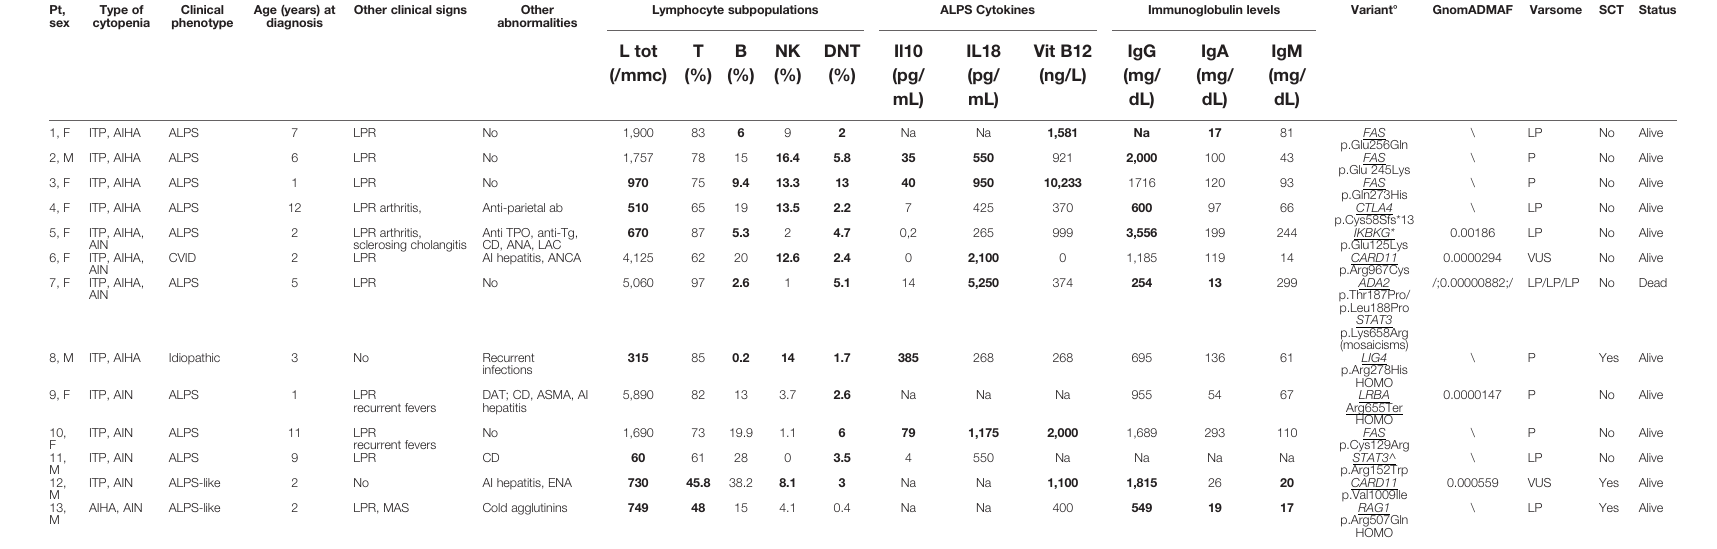
TABLE 2 | Clinical/immunological characteristics of patients carrying pathogenic/likely pathogenic variants related t o IEI (abnormal results in